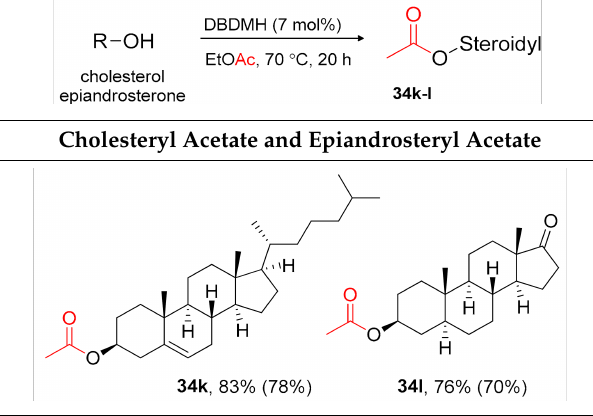
Table 7. Transesterification of cholesterol and epiandrosterone 1,2,3